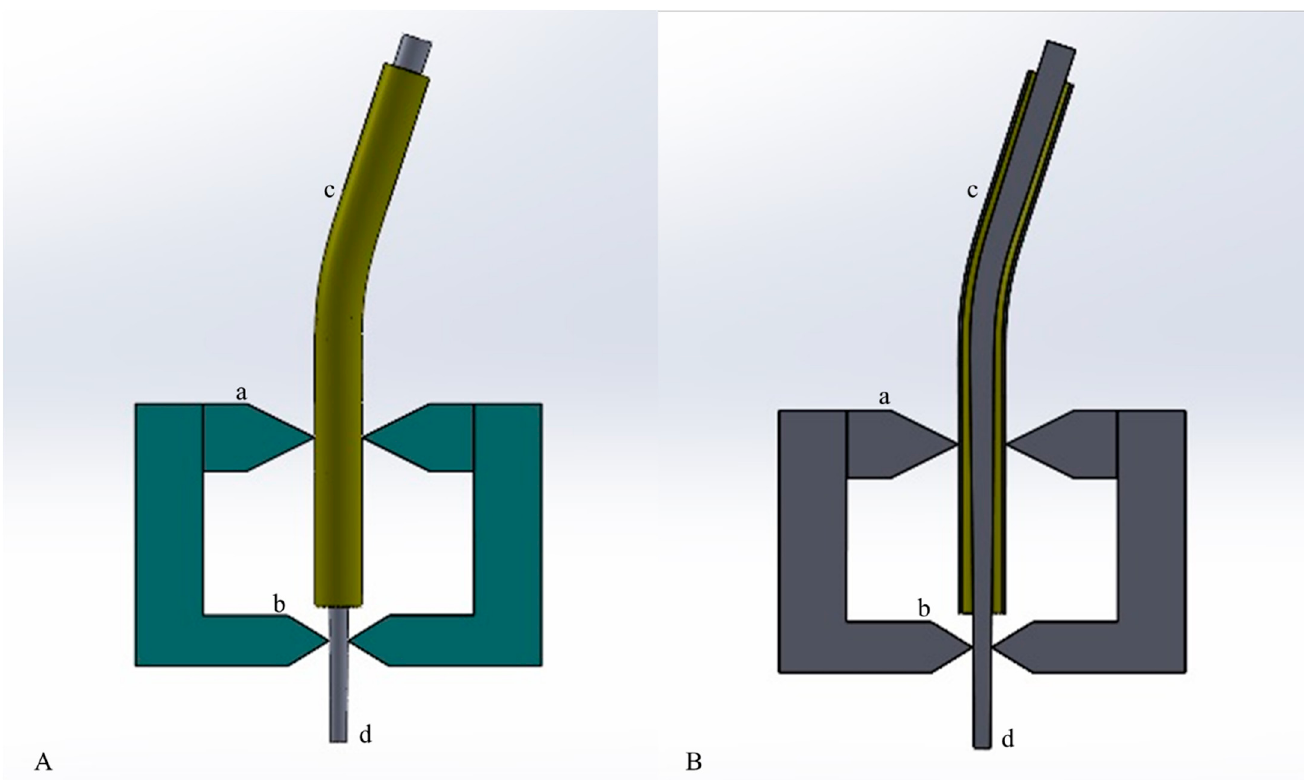
Figure 1. Schematic representation of the custom-made support apparatus simulating angulated access of NiTi instruments used in the static torsional test: ( A ) the support apparatus in its entirety, ( B ) its sectional view. (a) The upper part of the vise can fix the interchangeable artificial canal (20°-angled in figure); (b) the inferior part of the wise can firmly secure the instrument at 3 mm from its tip; (c) the artificial stainless-steel canal with predetermined curvature; (d) schematic representation of the NiTi instrument. The upper portion of the instrument is connected to the endodontic motor.